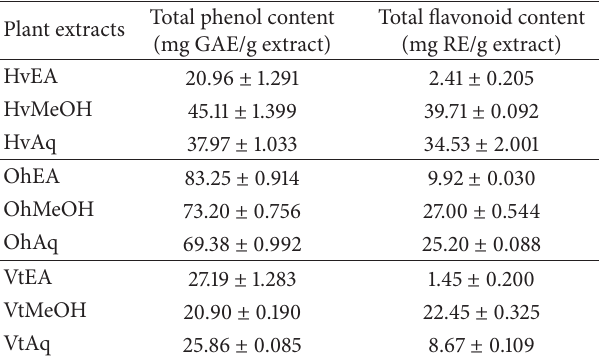
Table 1: Total phenol and flavonoid content of the plant extracts. Total phenol content Plant extracts (mg GAE/g